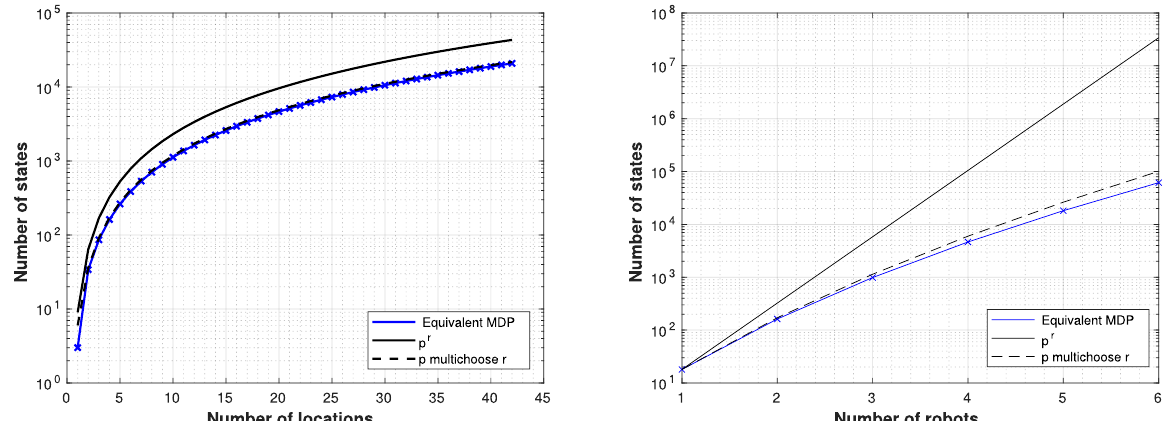
Figure 9. ( Left ) State space size as a function of the number of locations; ( Right ) State space size as a function of the number of robots, where p represents the number of places and r the number of tokens in the GSPNR model.